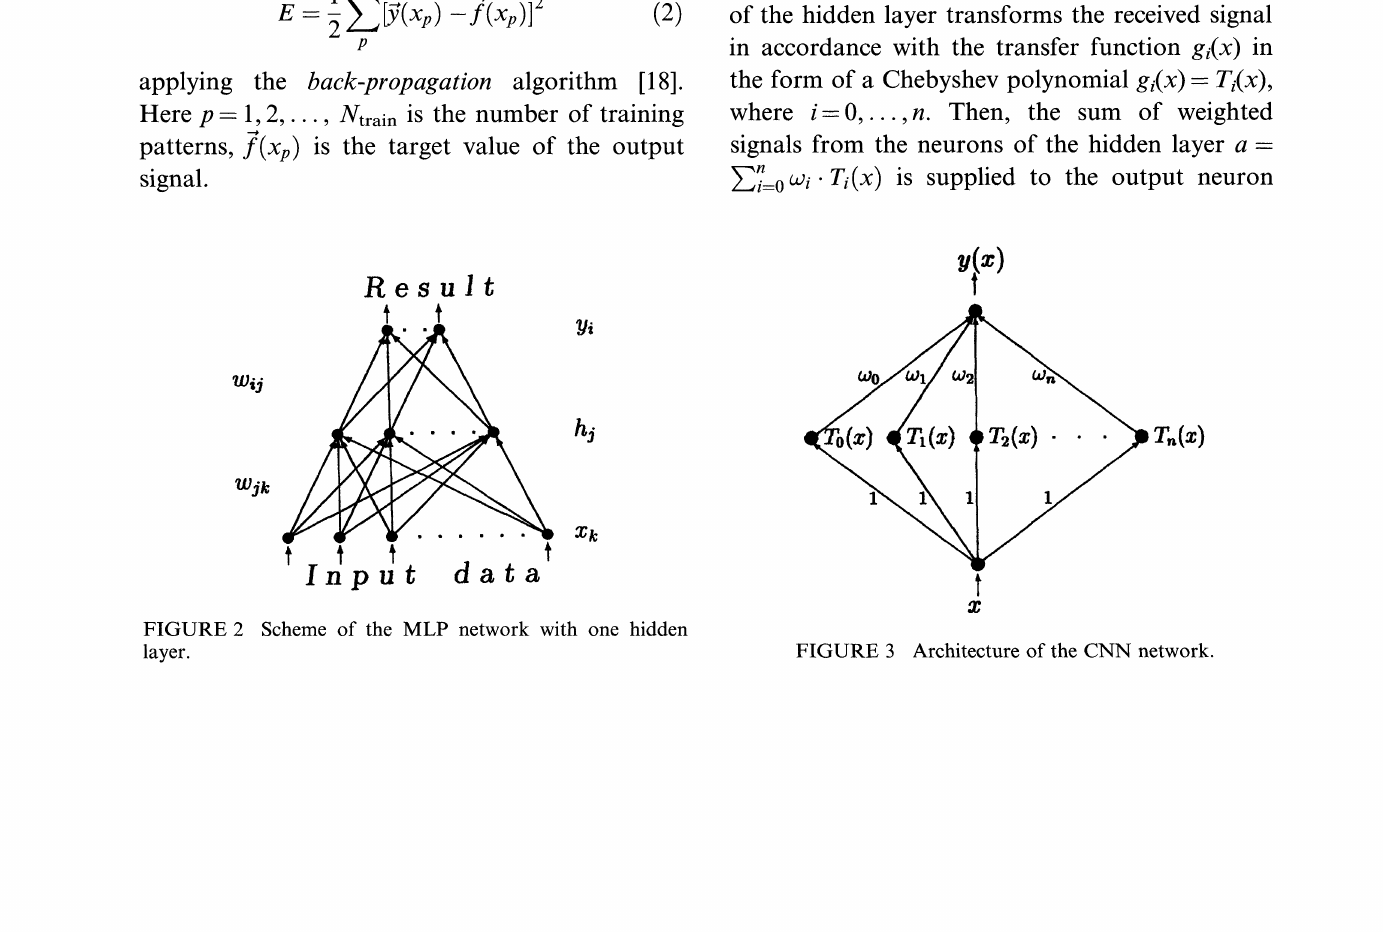
FIGURE 2 Scheme of the MLP network with one hidden layer. FIGURE 3 Architecture of the CNN